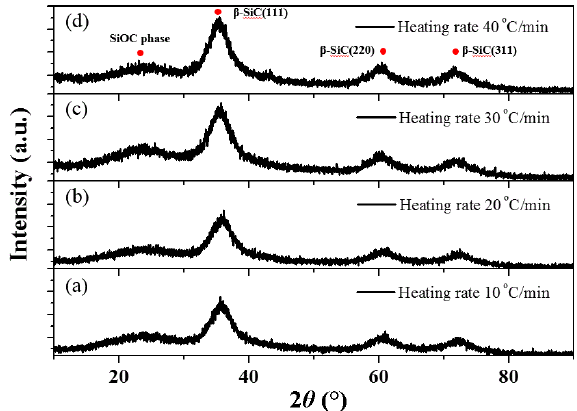
Fig. 4 XRD patterns of SiC fiber at different heating rates.